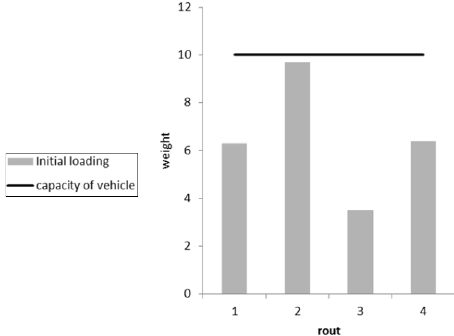
Figure 7. Compliance check for initial loading